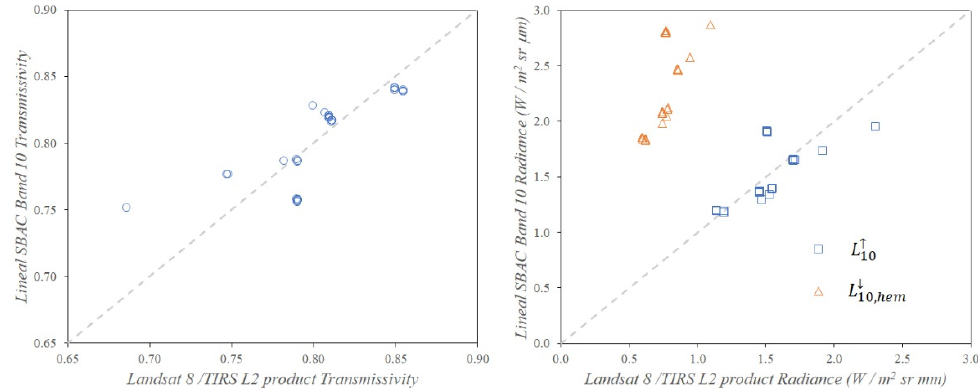
Figure 6. Atmospheric correction parameters retrieved using the linear approach proposed, versus those provided by the Landsat 8 LST L2 Product. Each point corresponds to one data in the validation databased used (Table 2). Dashed line shows the 1:1 agreement.